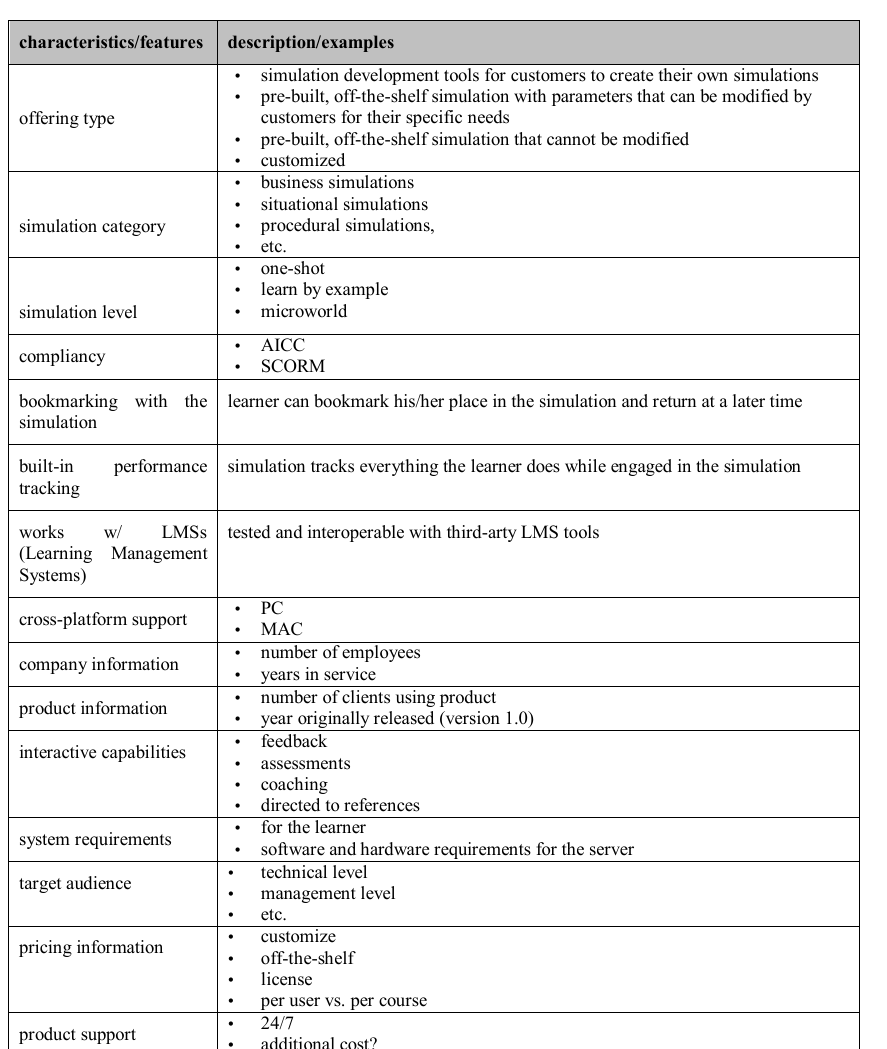
Table 1. Simulation comparative characteristics/features